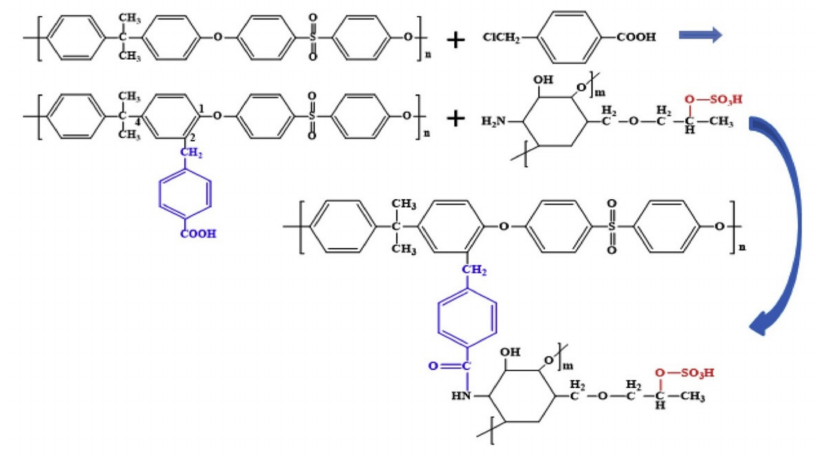
Figure 4. The modified polysulfone membranes obtained by grafting 4-(chloromethyl)benzoic acid and sulfonated hydroxypropyl chitosan (reproduced with permission after